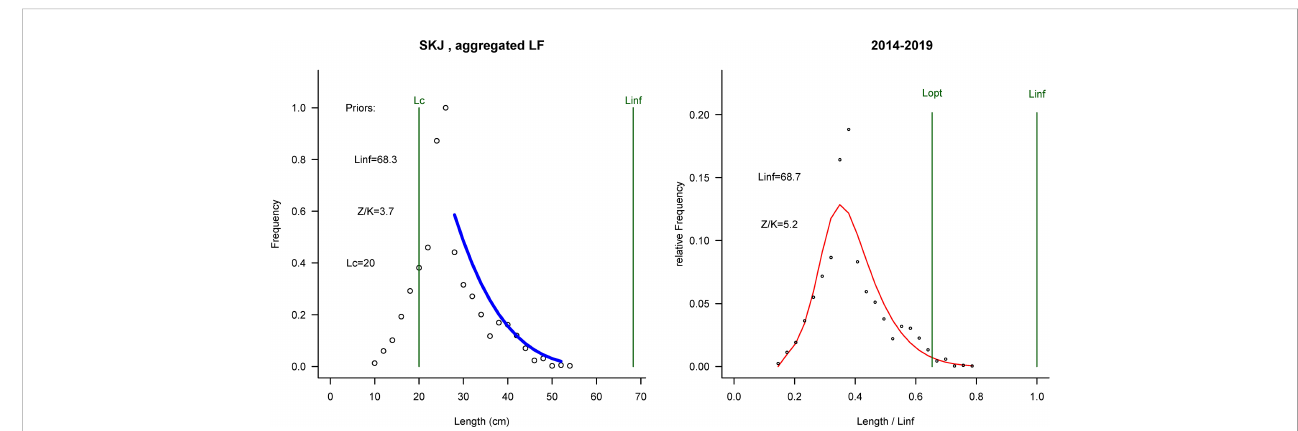
FIGURE 4 Length-based Bayesian biomass estimates for skipjack tuna in the South China Sea. Left: fi ts of the model to length data; right: predictions of the LBB analysis. L L inf , asymptotic length; c , length of 50% individuals captured by the gear;